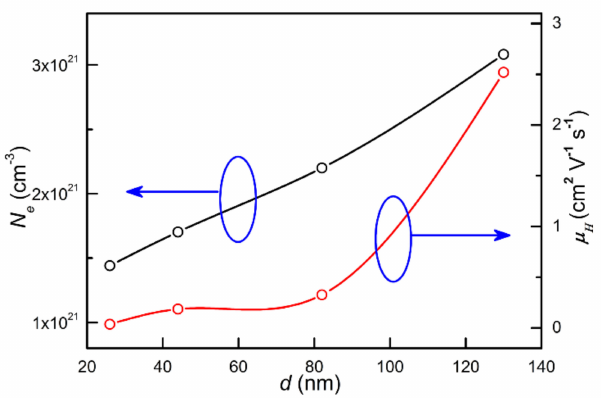
Figure 7. The electron carrier concentration and electron mobility dependence of the thickness for all derived CrN